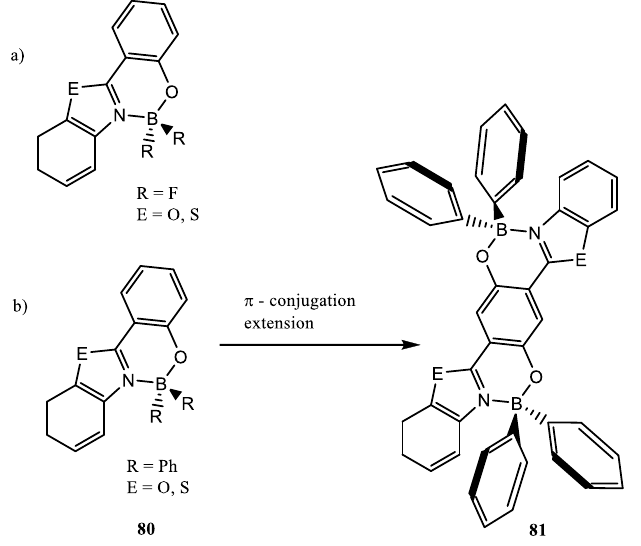
Figure 19. The design strategy towards diboron-containing complexes with a seven-ring fused π -conjugated skeleton ( a ) R = Fluorene based 2-(2’-hydroxyphenyl)benzoxazole and 2-(2’-hydroxy phenyl)benzothiazole ligands. ( b ) scheme of formation of fluorescent red and deep red boron containing complex.